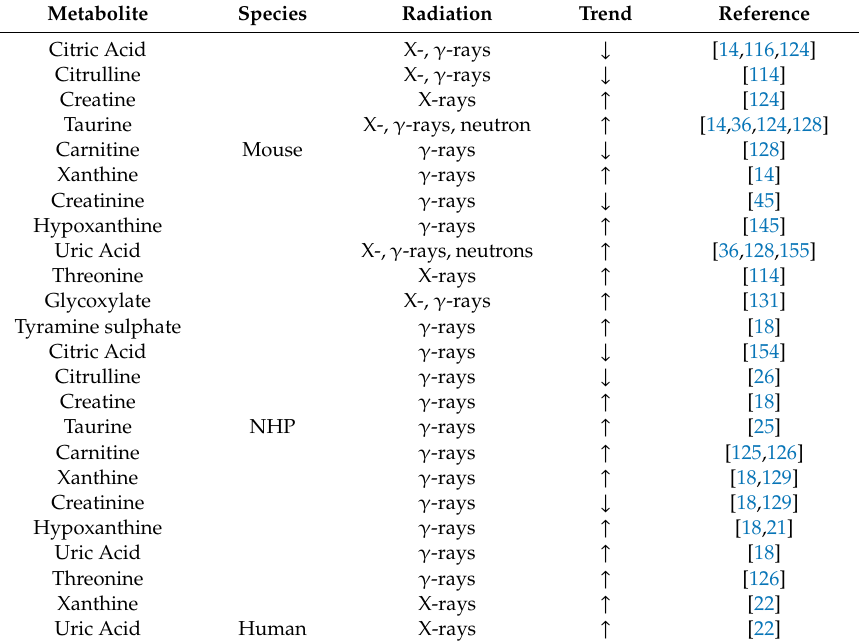
Table 2. Trends in metabolites following Total Body Irradiation